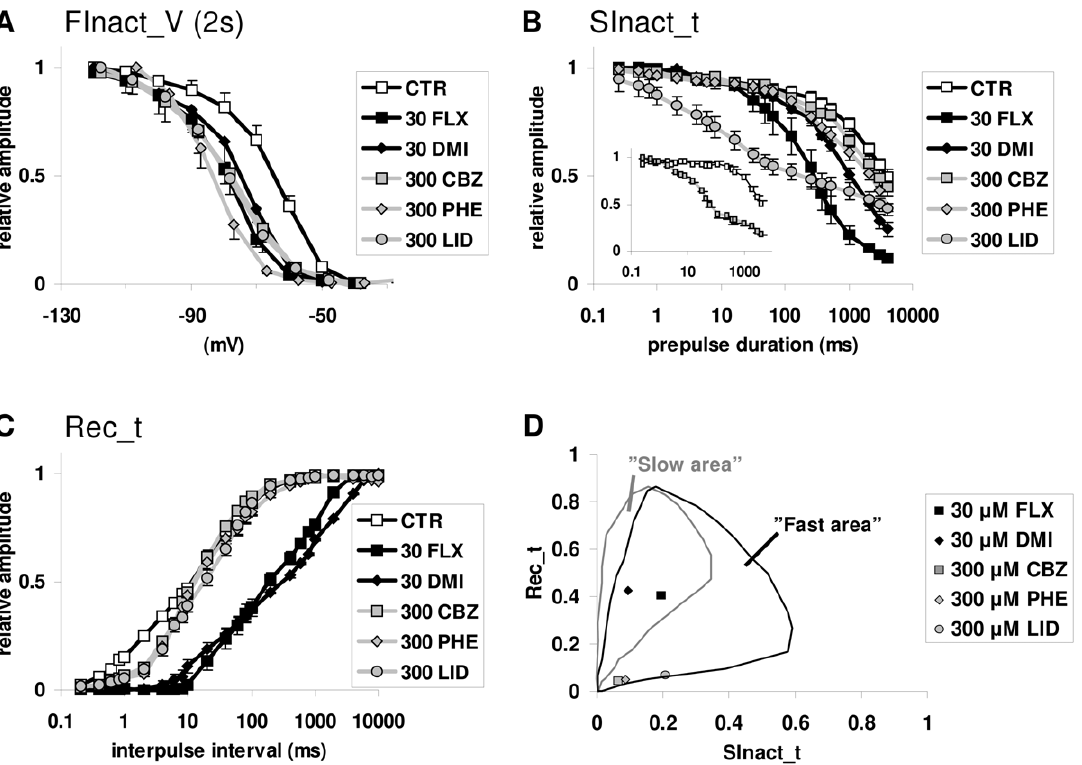
Figure 6. The effect of five SCIs in different voltage protocols. The following drugs were investigated: 30 m M fluoxetine (FLX, black squares ), 30 m M desipramine (DMI, black diamonds ), 300 m M carbamazepine (CBZ, gray squares ), 300 m M phenytoin (PHE, gray diamonds ) and 300 m M lidocaine (LID, gray circles ). A , ‘‘FInact_V’’ protocol. Pre-pulse duration was set to 2 s. All drugs produced a similar voltage shift. B , ‘‘SInact_t’’ protocol. Carbamazepine and phenytoin induced only a minor modification compared to the control. Fluoxetine and desipramine produced a definite shift. Lidocaine caused inhibition even in the time range of fast inactivation. C , ‘‘Rec_t’’ protocol. Unlike fluoxetine and desipramine, carbamazepine, phenytoin and lidocaine only affected the first phase of the curve, which corresponds with recovery from the fast-inactivated state. D , The nSOD(Rec_t) – nSOD(SInact_t) plots for the drugs that were studied. Fluoxetine and desipramine occupied the overlapping area; plots of carbamazepine, phenytoin and lidocaine fell into the area of fast-inactivated state